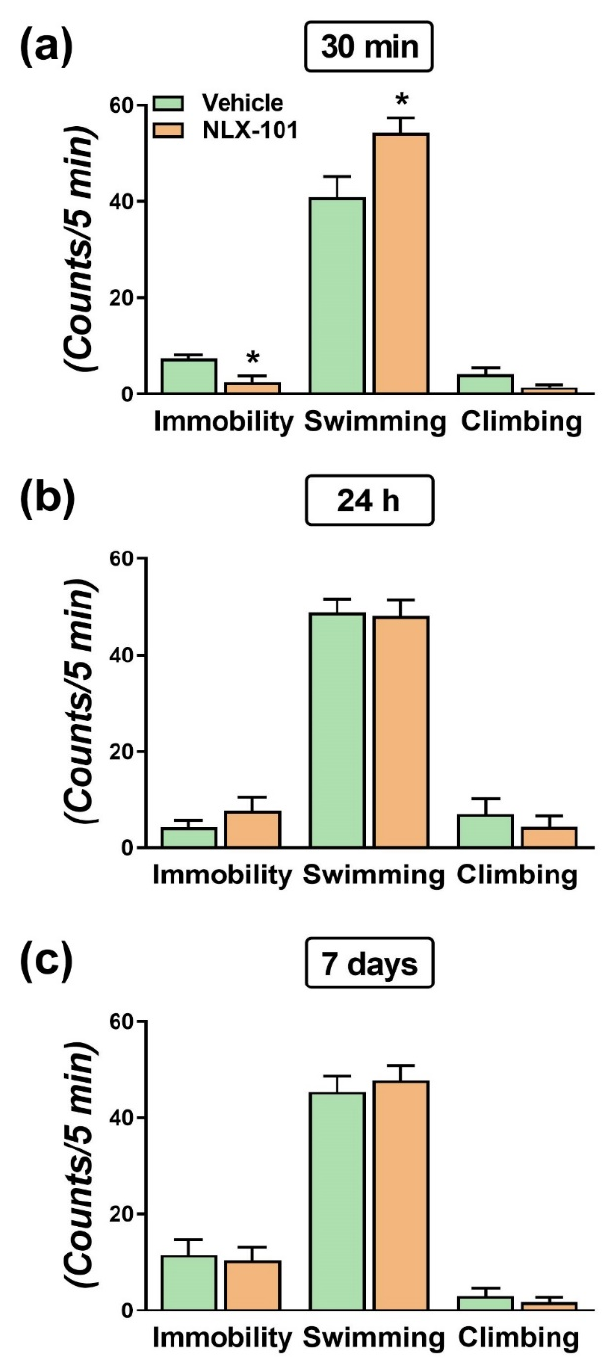
Figure 1. Antidepressant-like action of NLX-101 in the forced swim test (FST) conducted 30 min ( a ), 24 h ( b ) and 7 days ( c ) after the intraperitoneal injection of 0.16 mg/kg of NLX-101. Results are expressed as mean ± SEM of n = 5–6 rats/group, * p < 0.05, two-tailed Student’s t -test.